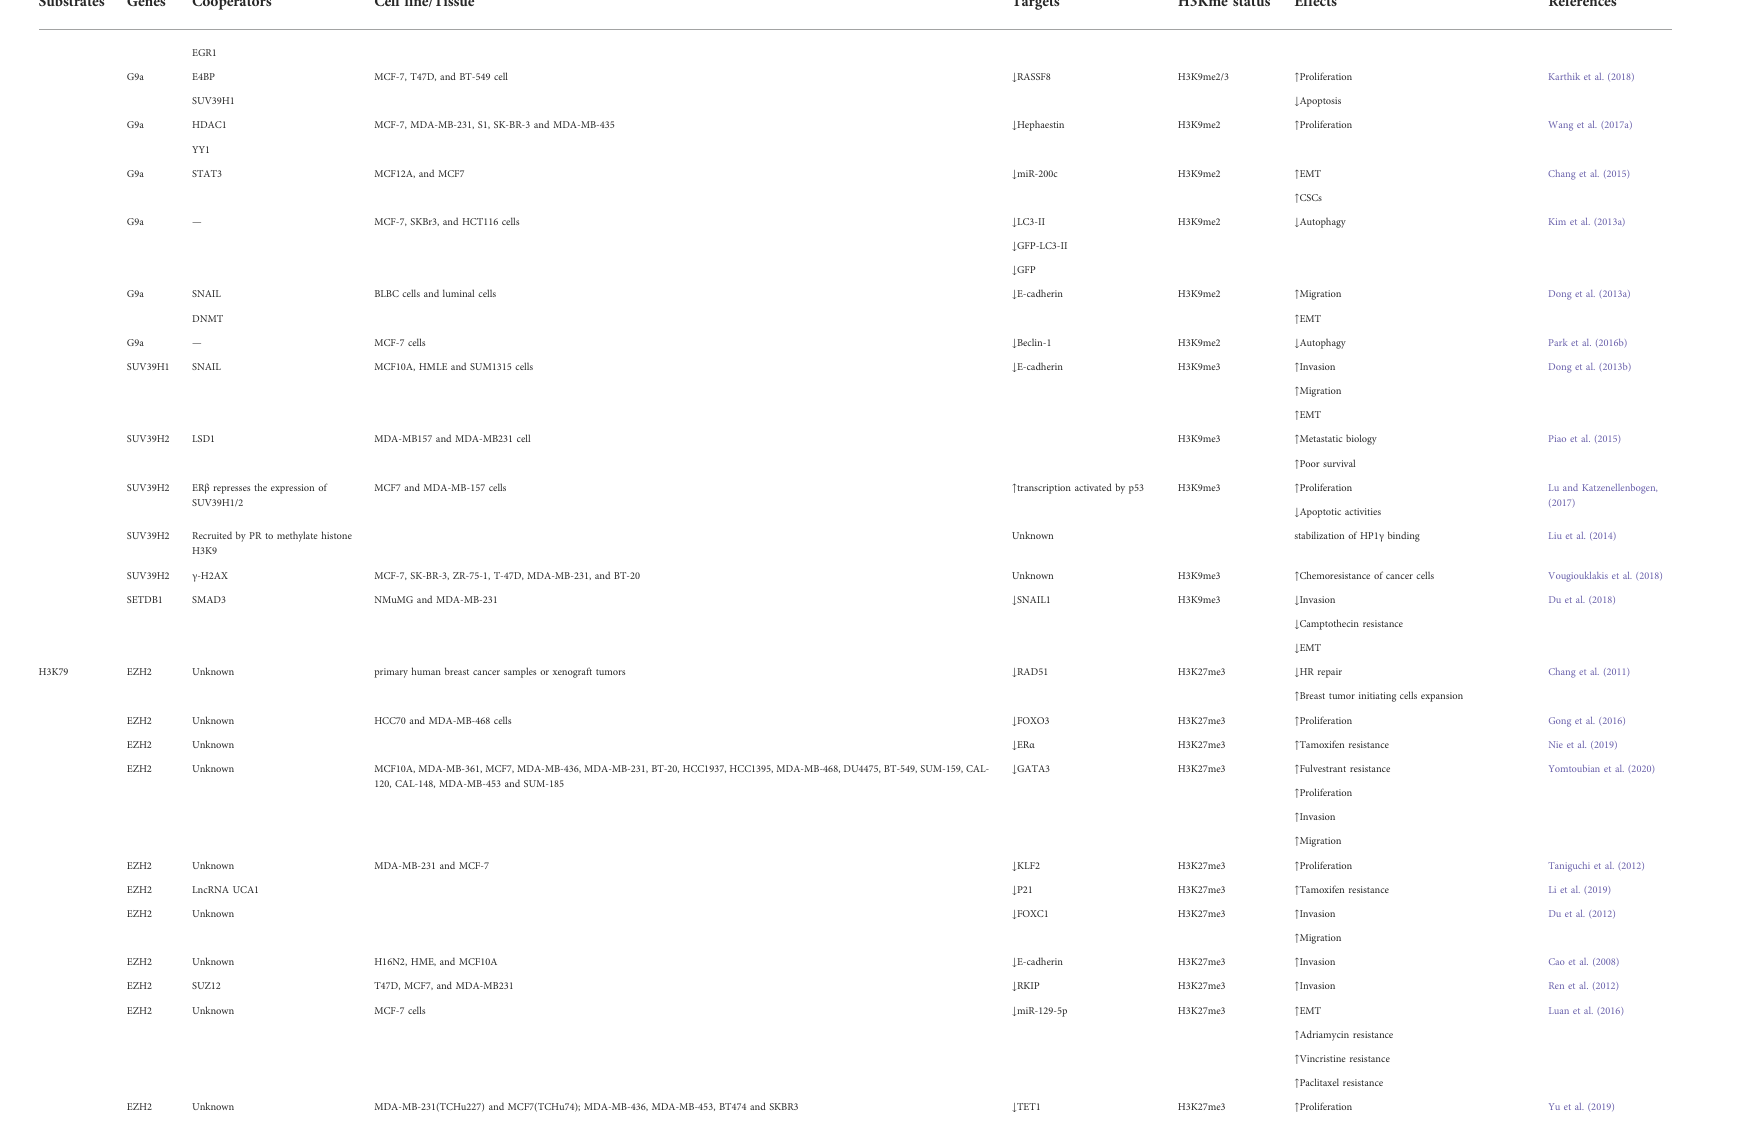
TABLE 1 ( Continued ) Status of histone methylation marks studied in breast cancer